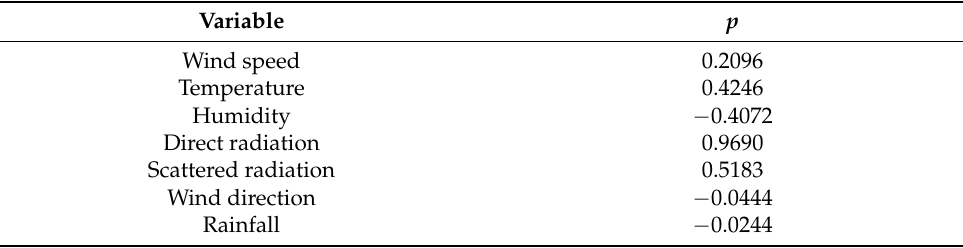
Table 2. Results of correlation analysis.